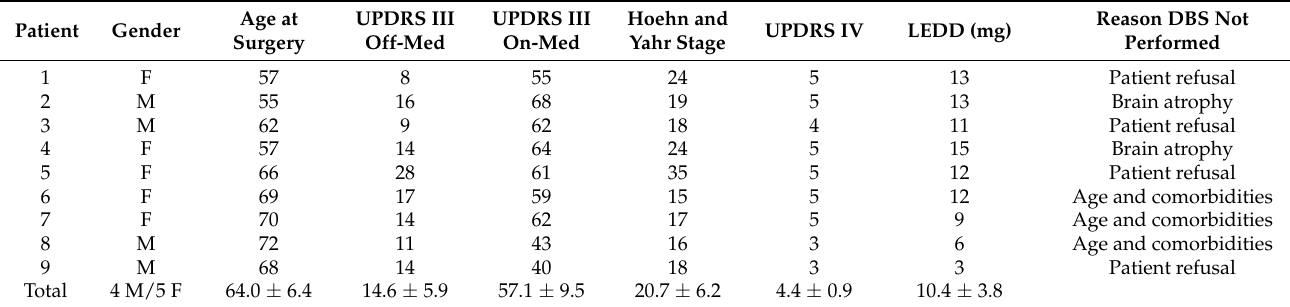
Abbreviations: UPDRS = Unified Parkinson’s Disease Rating Scale; DBS = deep brain stimulation.